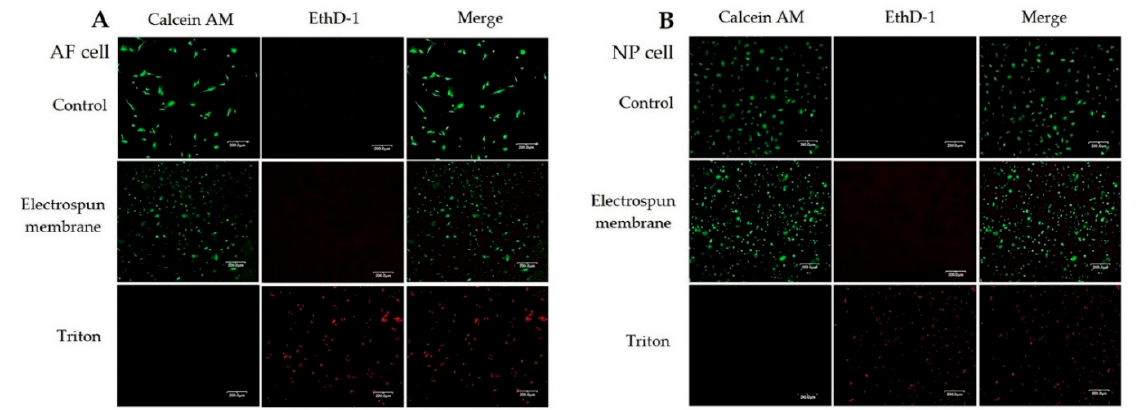
Figure 6. The results of live/dead staining: ( A ) primary AF cells, and ( B ) primary NP cells, cultured on the slide glass (control group), fibroin/gelatin electrospun membrane, or treated with Triton X-